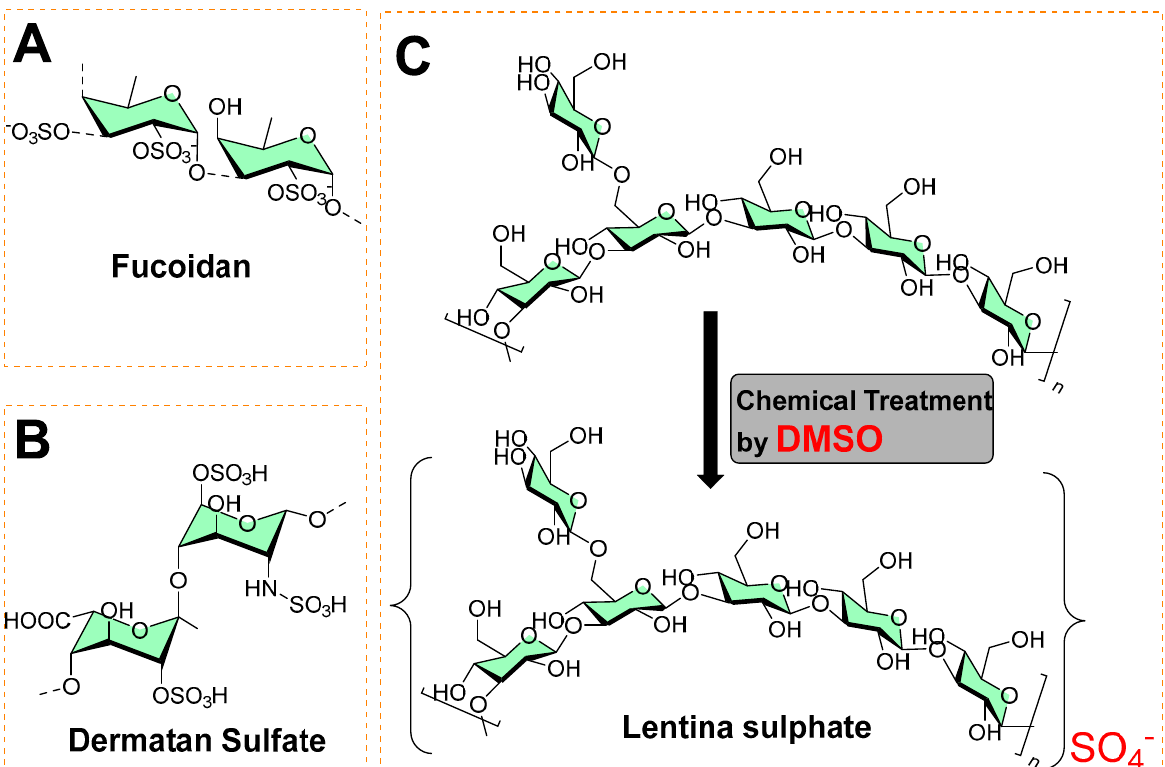
Figure 4. ( A ) Chemical structure of fucoidan. ( B ) Chemical structure of dermatan sulfate. ( C ) Chemical synthesis of lentina sulfate using DMSO.